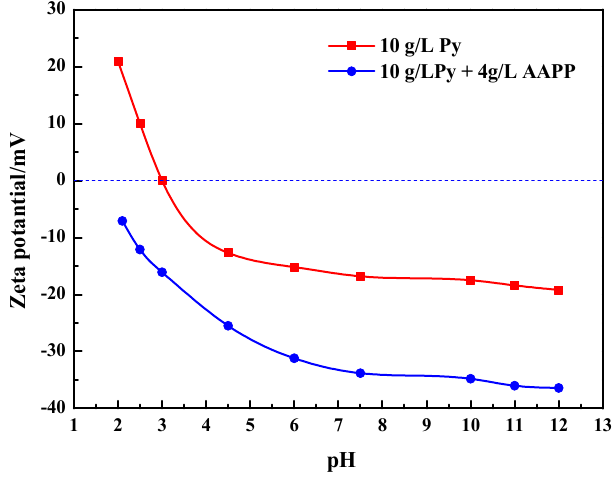
Figure 9. Zeta potential versus pH for pyrite in the absence and presence of 4 g/L AAPP.